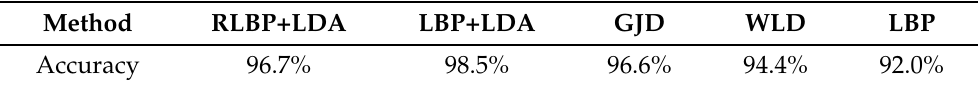
Table 5. Accuracy of our RLBP+LDA and LBP+LDA methods compared to other face classification algorithms discussed in [53], using the UCH-Thermalface [78] database.